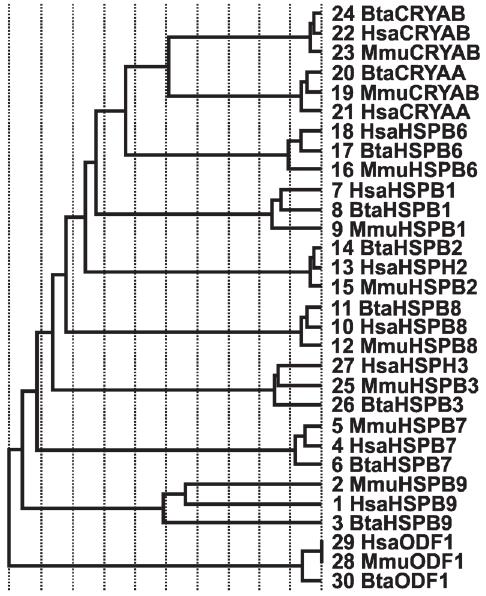
Figure 4. Sequence identity dendrogram of small heat shock proteins. The first three letters Hsa, Bta and Mmu corresponds to human, bovine and mouse, respectively, followed by the gene names. The numbers represent the sequence numbers used in the evolutionary trace